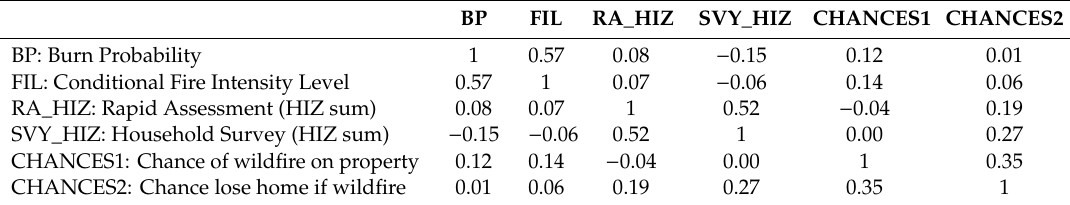
Table 2. Correlation coe ffi cients among assessment and survey variables (n = 1893); note that results from more sophisticated analyses are strongly preferred over